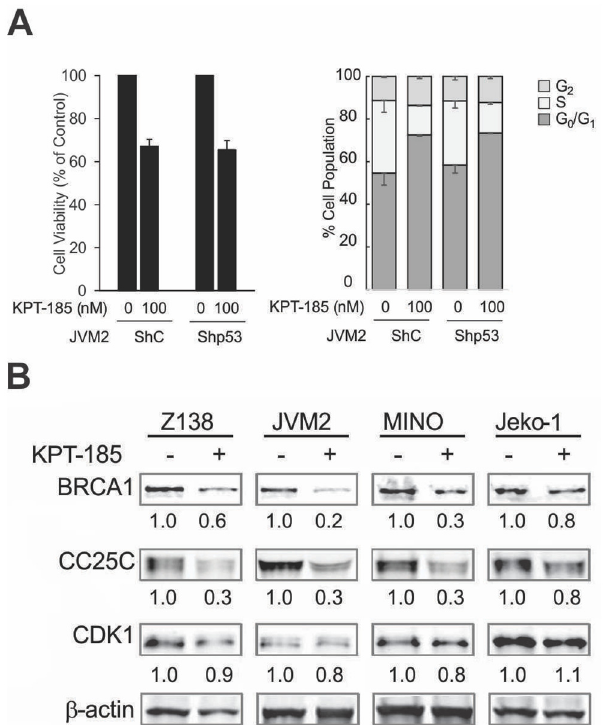
Fig 3. KPT-185 represses cell viability and cell cycle progression independent of p53-status. JVM2 cells stably transfected with control shRNA (shC) or p53 -specific shRNA (shp53) were treated with 100 nM KPT-185. (A) The cell viability was assessed by the Trypan blue dye exclusion method and displayed as percent of untreated control cells at 72 h. The percentage of G 0 -G 1 , S, and G 2 -M phase cells in the viable cell population was assessed at 48 h by PI flow cytometry (histograms for representative samples are shown). Graphs show the mean ± SD of results of three independent experiments. (B) After an 18-h treatment of KPT- 185, protein expression levels of CDC25C, BRCA1, CDK1 were analyzed by immunoblot as described in Fig 2. The results are representative of two independent experiments.